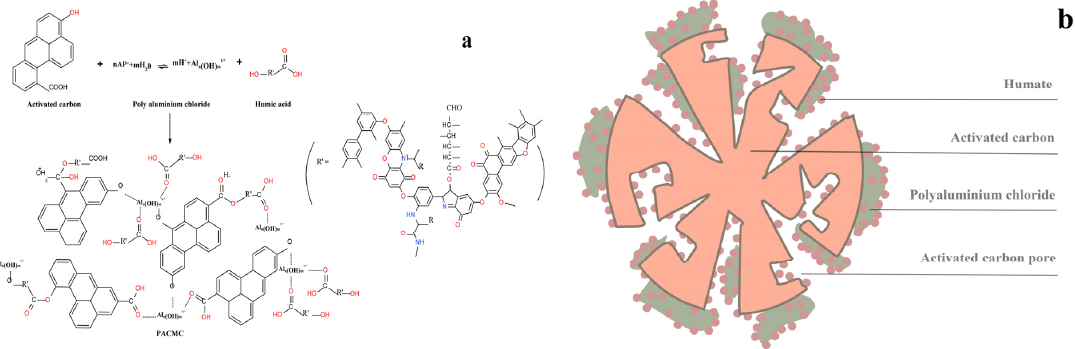
Figure 4. ( a ) Preparation route of PACMC. ( b ) A schematic microstructure illustration for PACMC.